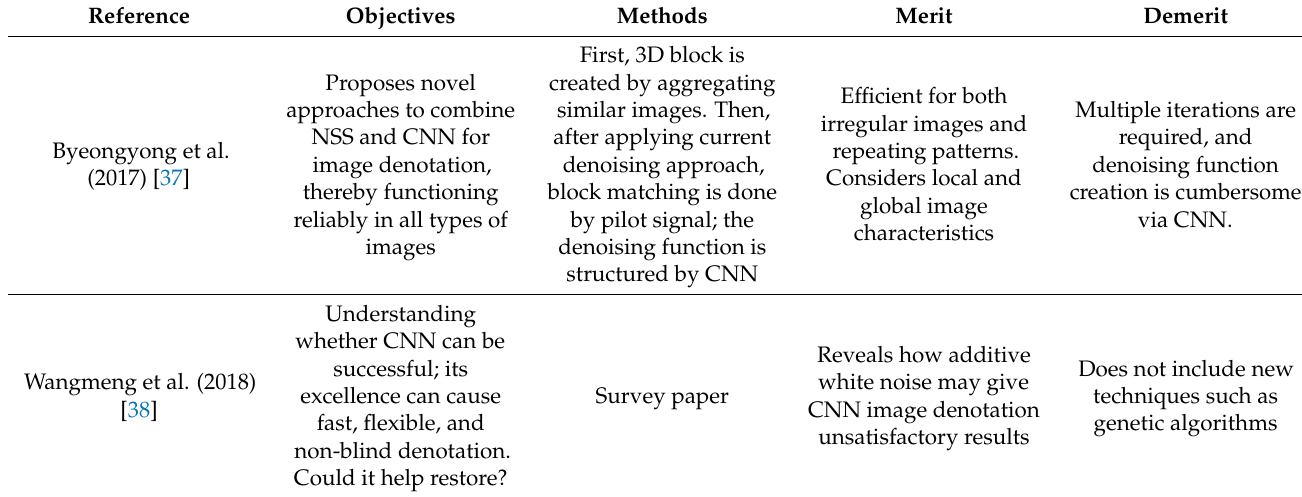
Table 1. A summary of existing methods of image denoising using deep learning